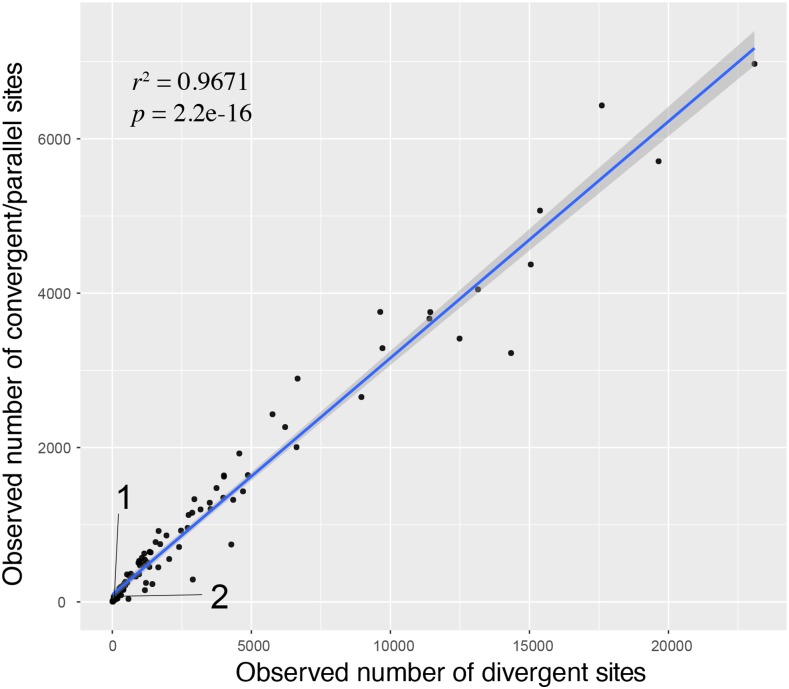
Correlation between observed number of divergence sites and observed number of convergent and parallel sites. Each data point represents one pairwise comparison between two branches, including both exterior and interior branches. Data point 1 = the Shedao pit-viper vs. the western painted turtle; data point 2 = the Shedao pit-viper vs. the American alligator.